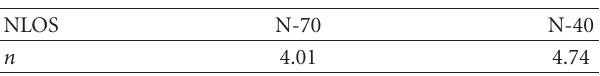
Table 3: Path loss exponents and standards deviations in